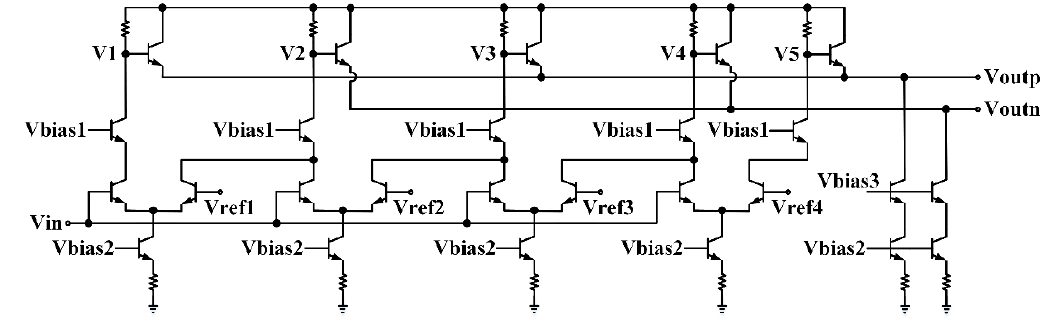
Figure 4. The folding amplifier in the first stage.